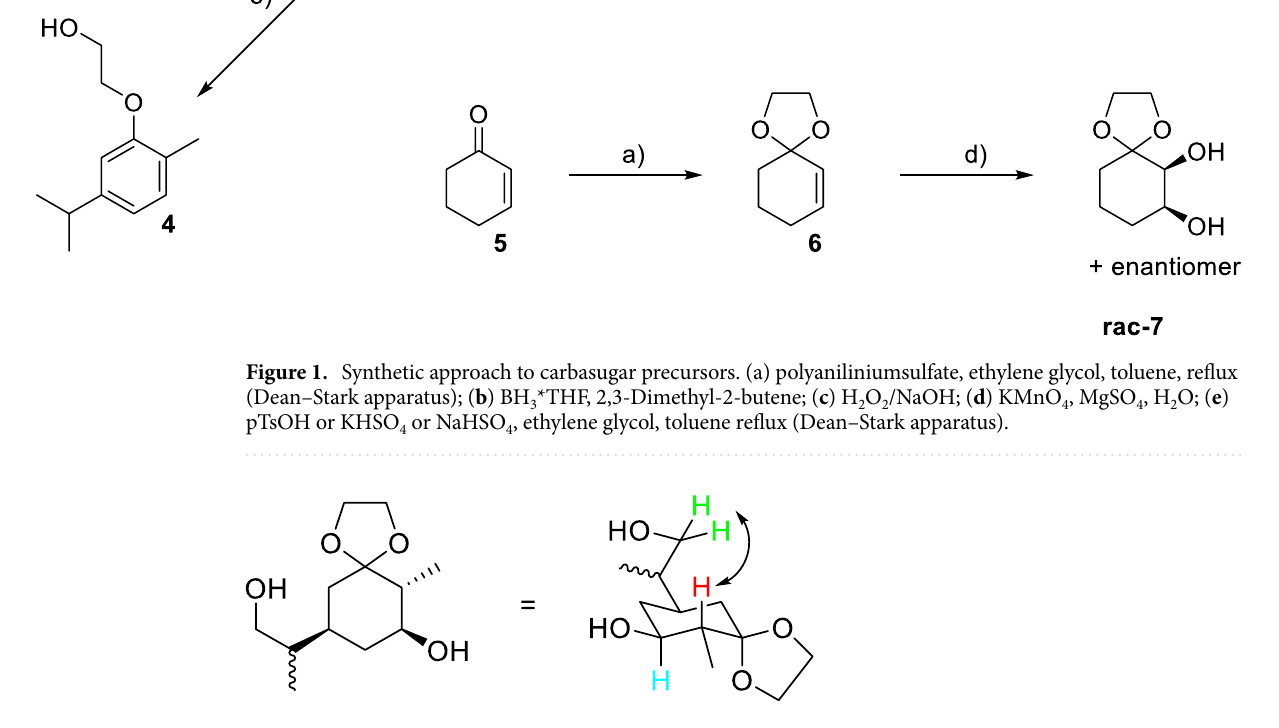
Figure 2. Chair conformation of compound 3 with indicated coupling in 2D